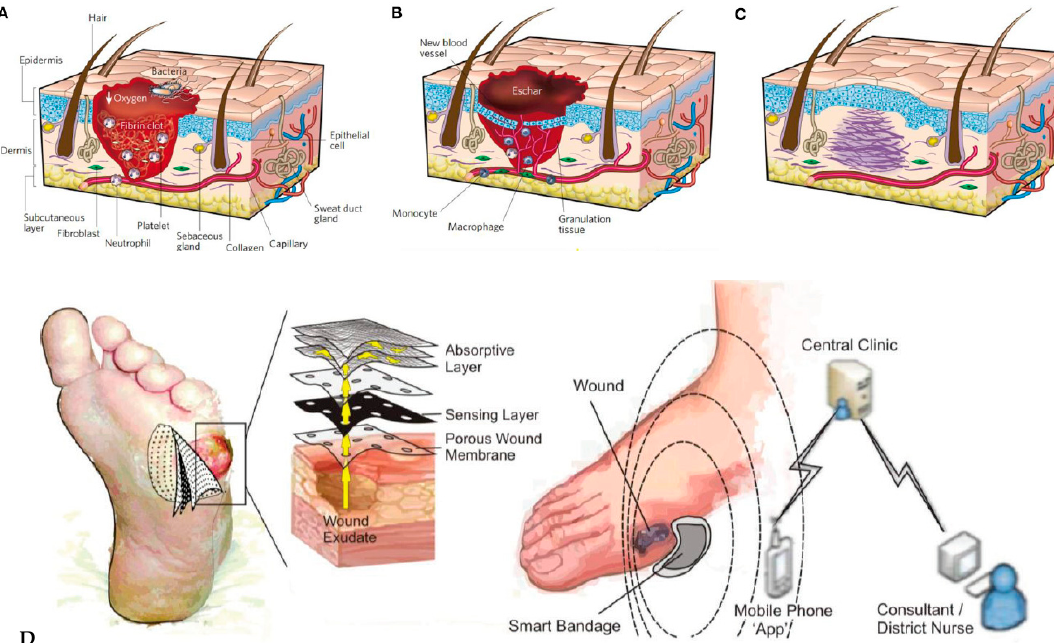
Figure 28. The three wound healing stages: ( A ) inflammation, ( B ) proliferation, and ( C ) remodeling. Reproduced from [89] with permission. Copyright © 2008, Springer Nature. ( D ) The general implementation and operation of a smart dressing. Reproduced from [79] Creative Commons Attribution License.